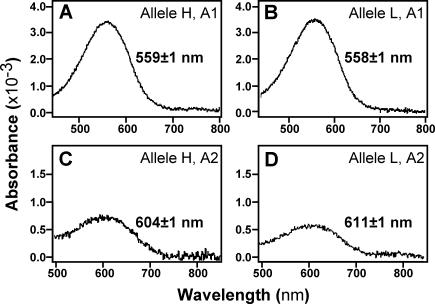
Absorption Spectra of the LWS Pigments Evaluated by the Dark–Light Difference SpectraThe LWS pigments were reconstituted from (A) H allele with A1 retinal, (B) L allele with A1 retinal, (C) H allele with A2 retinal, and (D) L allele with A2 retinal. The λmax values are indicated with their standard errors.